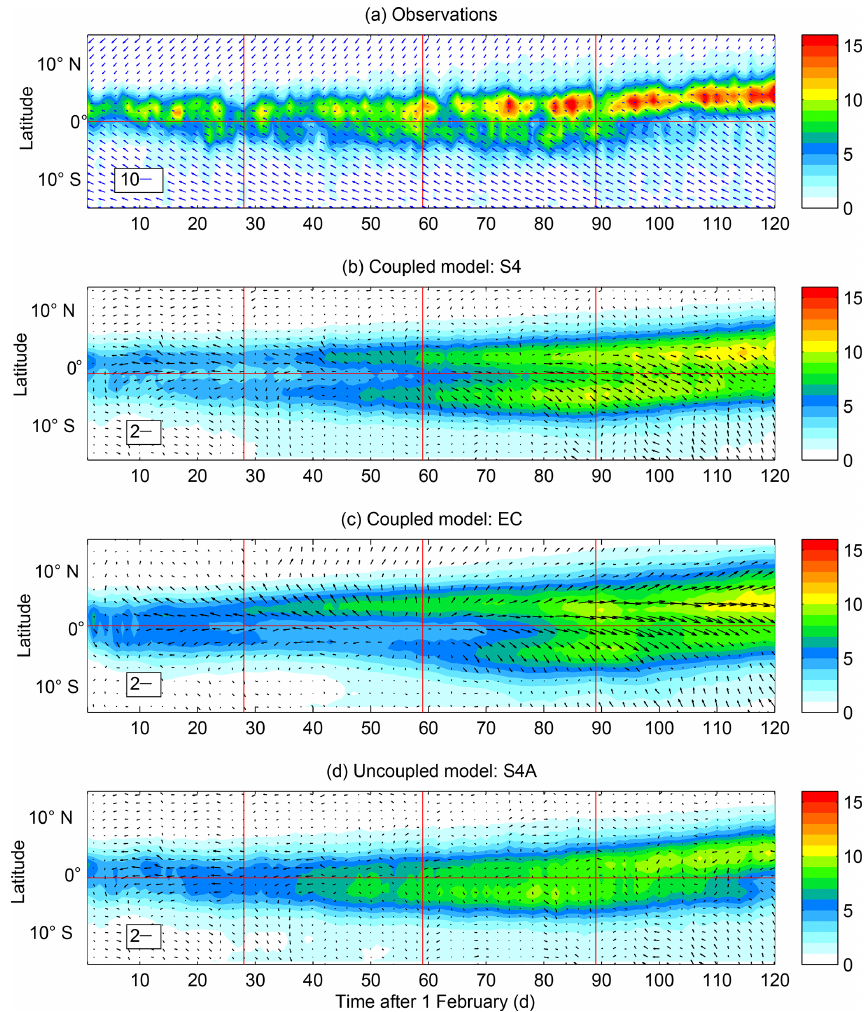
Figure 3. Latitude–time plot showing the evolution of model biases, all averaged over longitudes 40–0 ◦ W. Panel (a) shows observed rainfall as filled contours, with observed mean vector wind at 10m (blue arrows). Panels (b) to (d) show the rainfall according to the three models, with the wind vector biases included as black arrows. Note that the wind vectors point in the direction they would if they were on a map; the horizontal dimension here is time rather than distance. Red lines show the Equator and the boundaries between months. Rainfall is in millimetres per day (see colour bar); wind is in metres per second (see legend). Averaged over years 1996 to 2009 (S4 and S4A) and years 1981 to 2000 (EC). TRMM rainfall data in panel (a) is averaged over years 1998 to